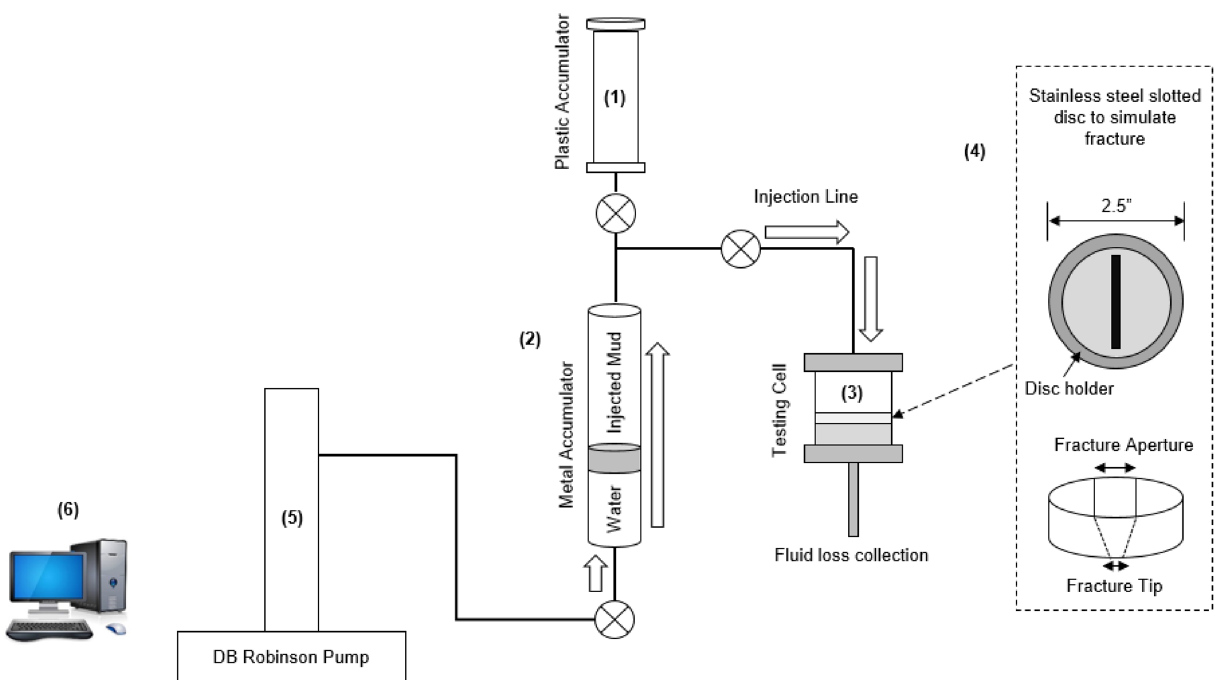
Fig. 1 Schematic diagram of the experimental setup for particle bridging tests at high and low pressures. ((1) A plastic accumula- tor; used to transfer the drilling fluids, (2) A metal accumulator;